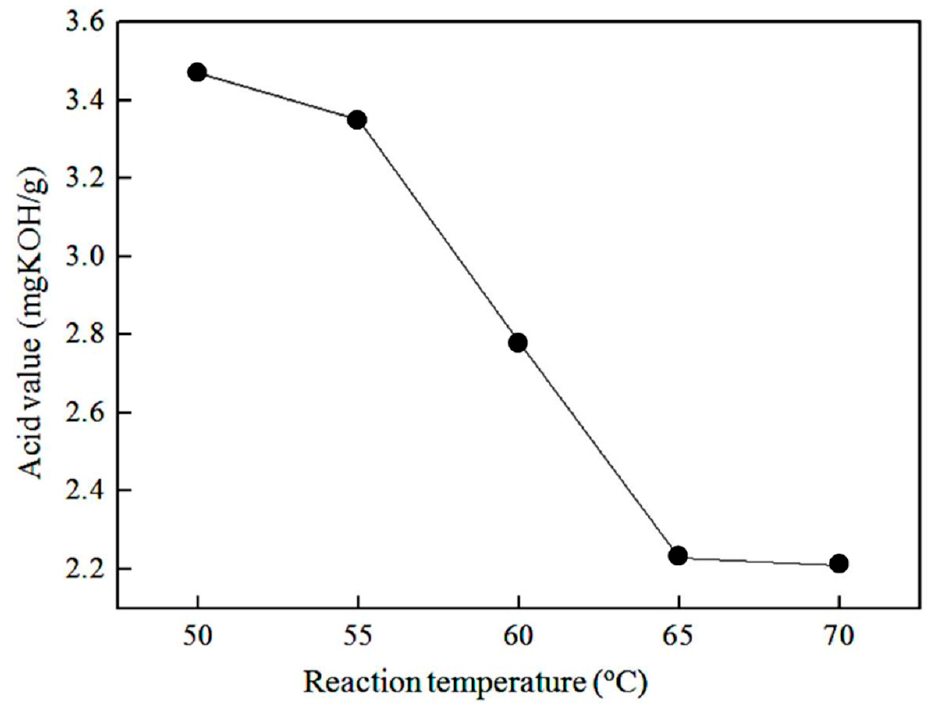
Figure 3. Effect of reaction temperature on the acid value.